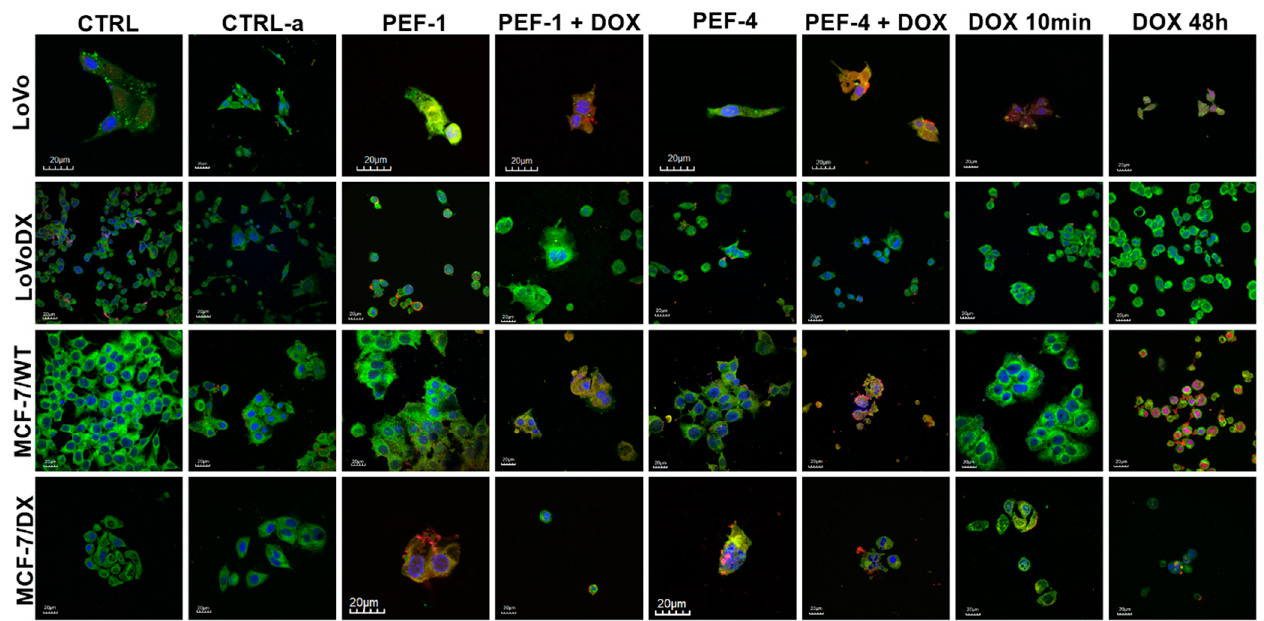
Figure 8. The visualization of mitochondria (green) and ROS (red) in colon and breast cancer cells after PEF1 and PEF4 with/without doxorubicin (DOX, C DOX = 2 μ M).